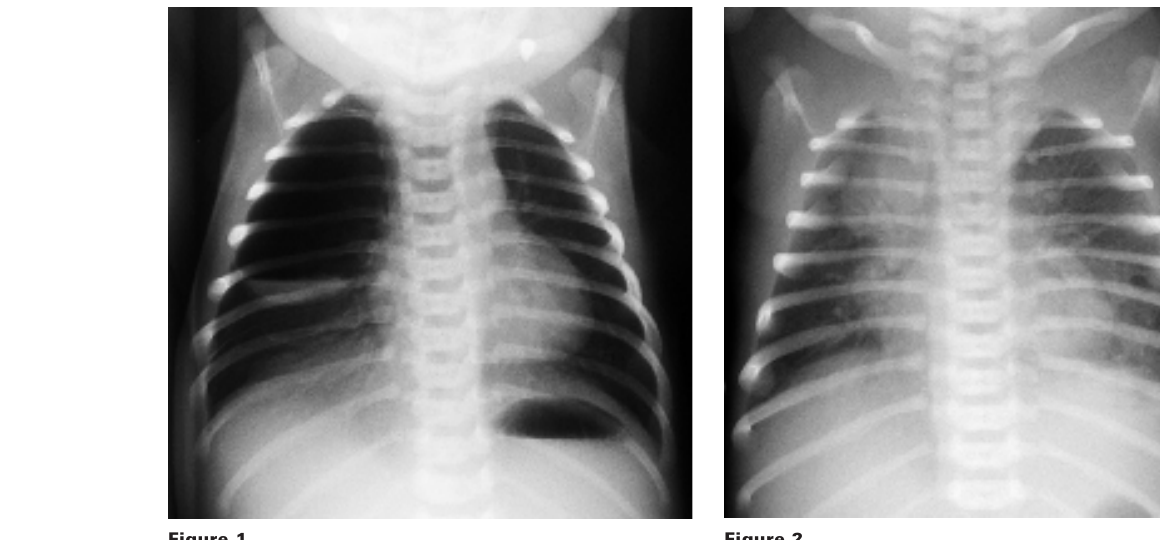
Figure 1 Congenital lung cyst. Chest radiograph of a 4-day-old boy with a single large cyst in the right upper lobe, containing air and fluid. The cyst caused some compression of the sur- rounding lung tissue, and the baby presented with moderate tachypnoea.